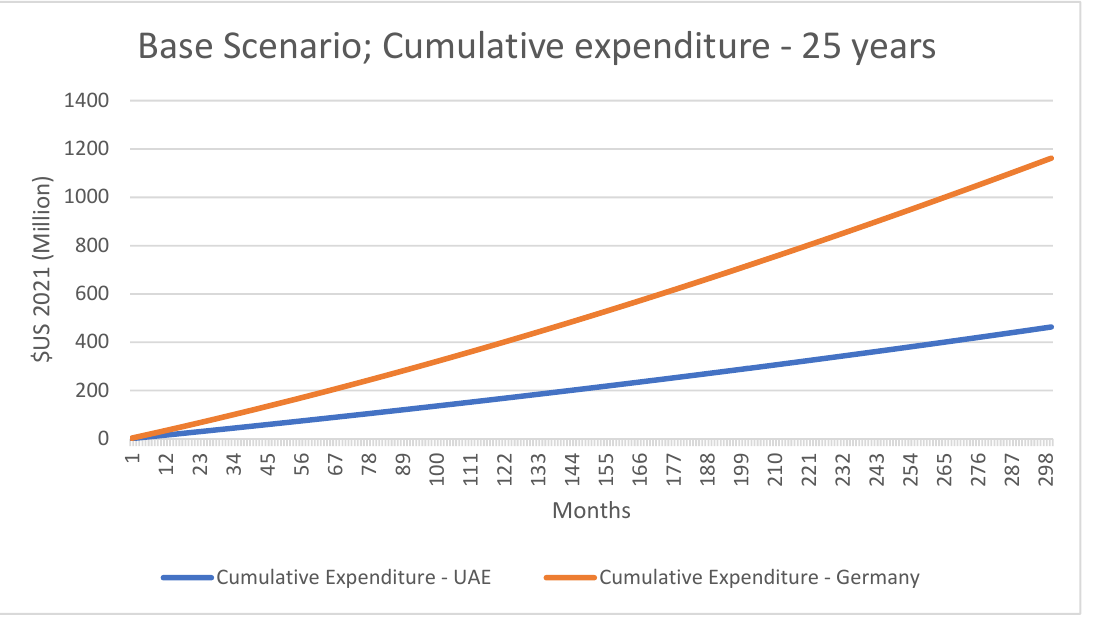
Figure 6. Cumulative expenditure through electricity consumption for UAE and DE under the base scenario.